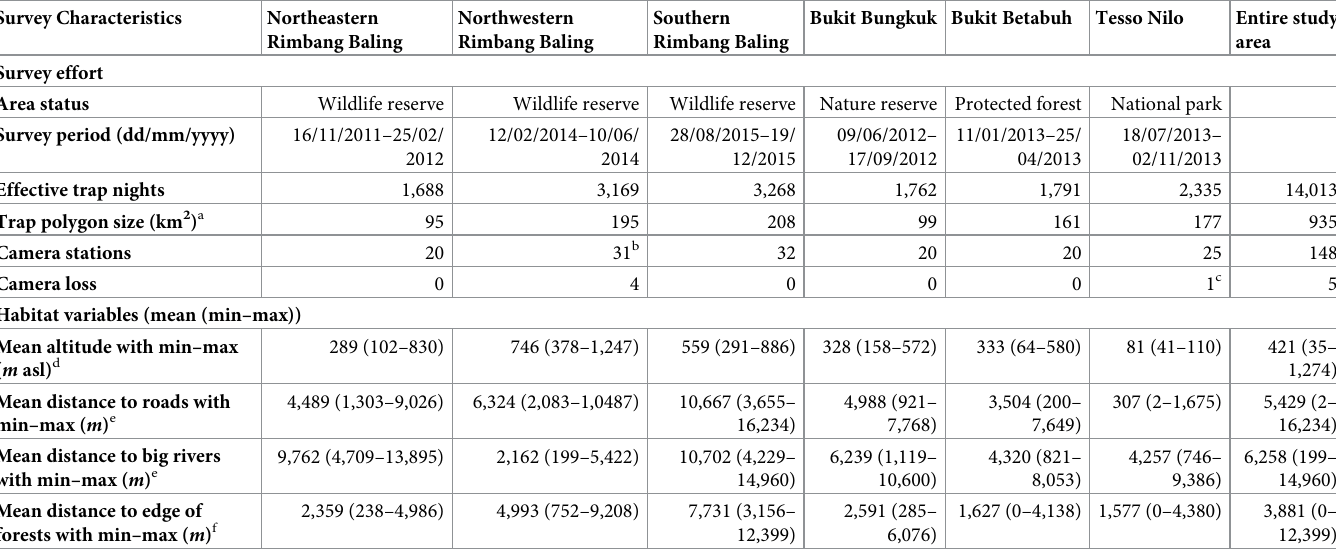
Table 1. Survey efforts and characteristics of all study sites within four major protected